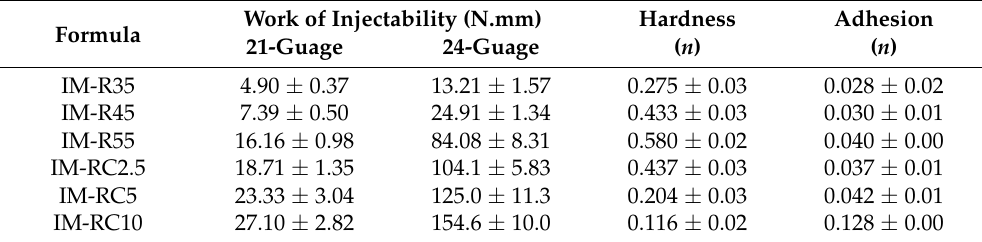
Table 1. Characterization of the injectability and mechanical properties of IM-loaded rosin/CO-based ISG formulations. ( n = 3). Work of Injectability (N.mm) Hardness Adhesion Formula